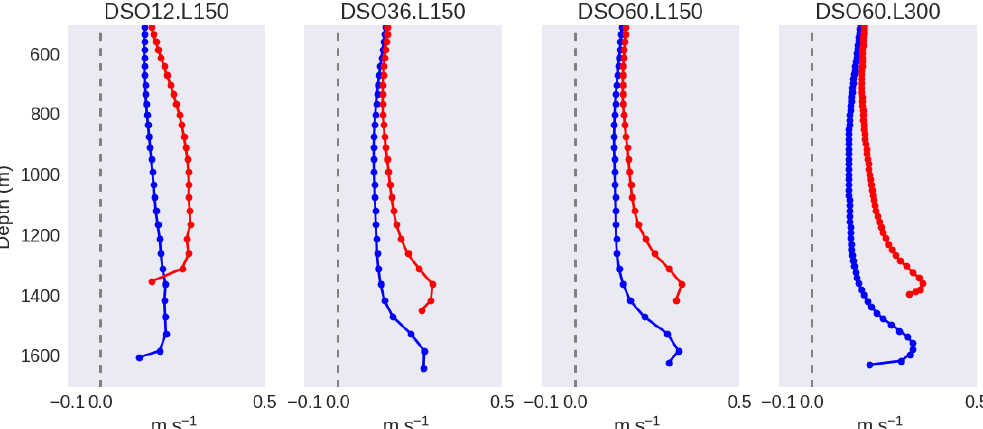
Figure 13. Vertical profiles (annual mean) of the quasi-along-slope velocity (i.e. velocity normal to the section) at the two locations of section 20 indicated in Fig. 6d for simulations (a) DSO12.L150, (b) DSO36.L150, (c) DSO60.L150, and (d)